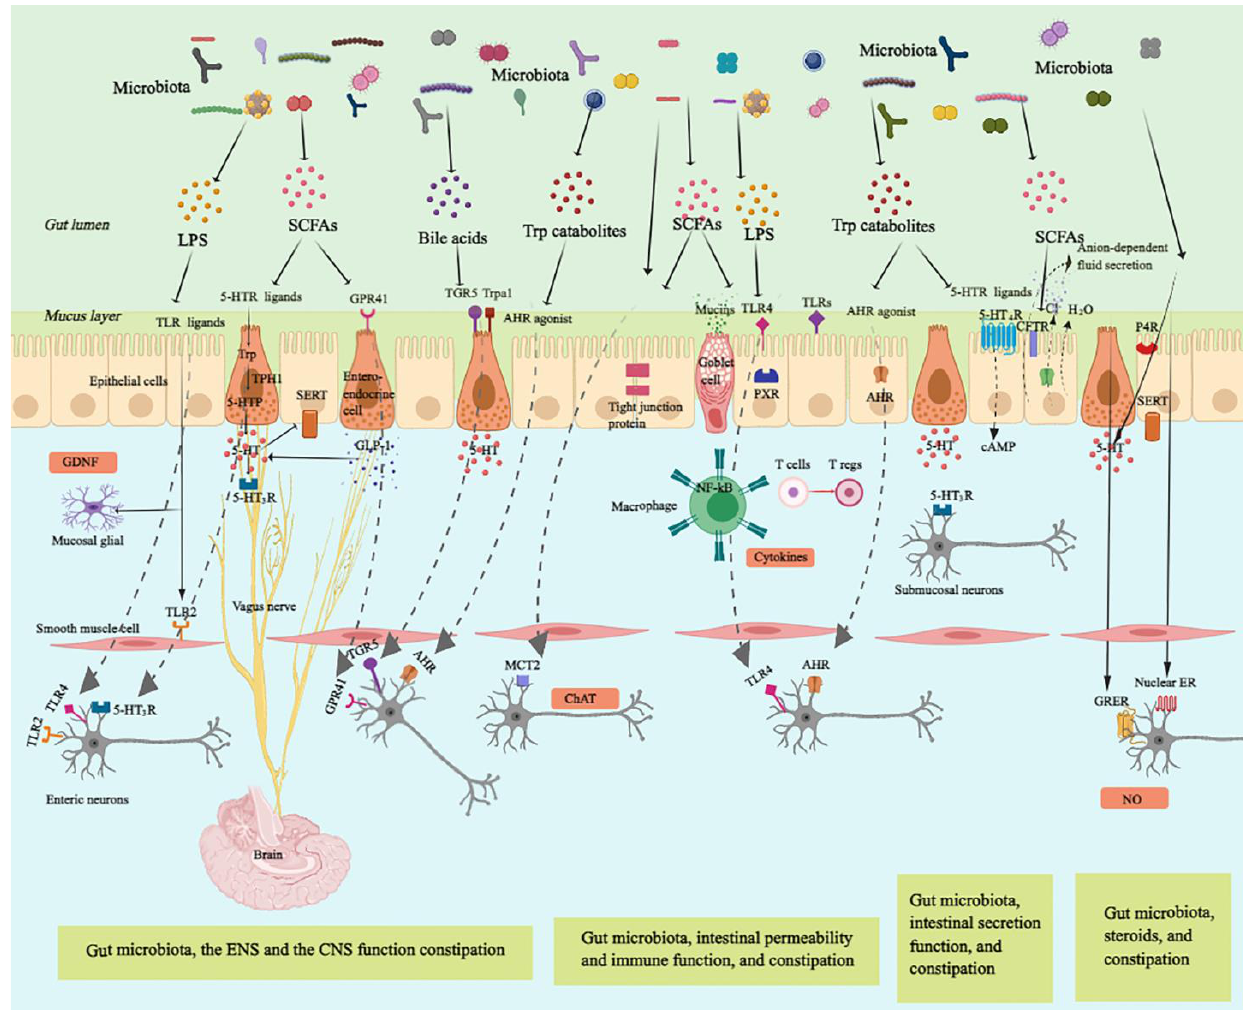
Figure 1. Mechanisms by which the microbiome and metabolites modulate the physiology of constipation. The gut microbiome and its metabolism impact host GI functions via regulation of the ENS, the CNS, the immune system, intestinal secretion, and the hormonal milieu. Notably, microbial-derived SCFAs and indole serve as ligands of 5-HTRs, TLRs, and AHR in the host, thereby facilitating microbiota-mediated functions. For example, the gut microbiome can influence TLR signaling, thereby mediating subsets of enteric neurons and gastrointestinal motility. The metabolite indole activates AHR to maintain mucosal immunity and homeostasis and 5-HT4R to increase colonic fluid secretion and accelerate gastrointestinal transit. Abbreviations: AHR, aryl hydrocarbon receptor; cAMP, cyclic AMP; CFTR, cystic fibrosis transmembrane regulator; ChAT, choline acetyltransferase; CNS, central nervous system; ENS, enteric nervous system; ER, estrogen receptor; GDNF, glial cell-derived neurotrophic factor; GLP-1, glucagon-like peptide-1; GPER, G protein coupled estrogen receptor; LPS, lipopolysaccharide; P4R, progesterone receptors; MCT2, monocarboxylate transporter 2; SCFAs, short-chain fatty acids; SERT, serotonin-selective reuptake transporter; Trp, Tryptophan; TPH1, tryptophan hydroxylase 1; Trpa1, transient receptor potential ankyrin A1; 5-HT, serotonin; TLR, Toll-like receptor; 5-HTP, 5-hydroxytryptophan.